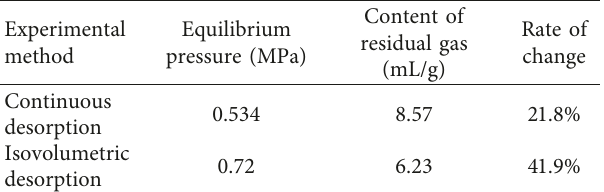
Table 3: Variation of coal resistivity following continuous de- sorption and isovolumetric desorption.